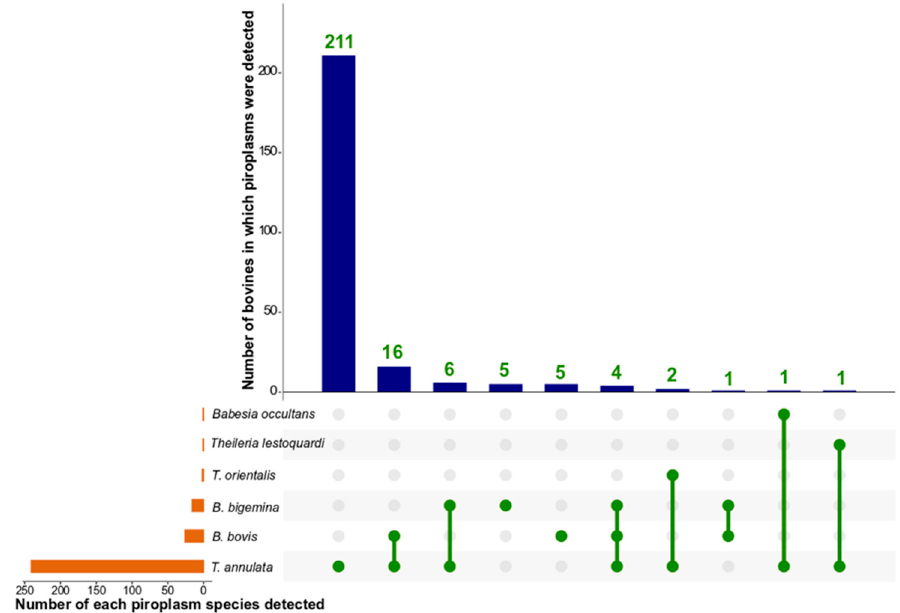
Figure 4. An UpSetR plot of Babesia and Theileria species detected in the tested bovine population in Pakistan by using PCR-based next-generation (deep) sequencing (NGS). The orange horizontal coordinate columns represent the number of samples which were test-positive for each piroplasm species. The blue vertical columns show the numbers of bovines that are positive for single or coinfections of piroplasm species. The green lines connecting green dots indicate coinfecting piroplasm species.